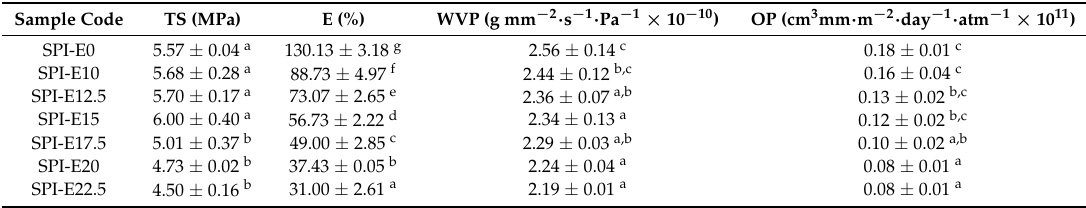
Table 2. Tensile strength (TS), elongation to break ( E ), water vapor permeability (WVP), and oxygen permeability (OP) of the SPI-based